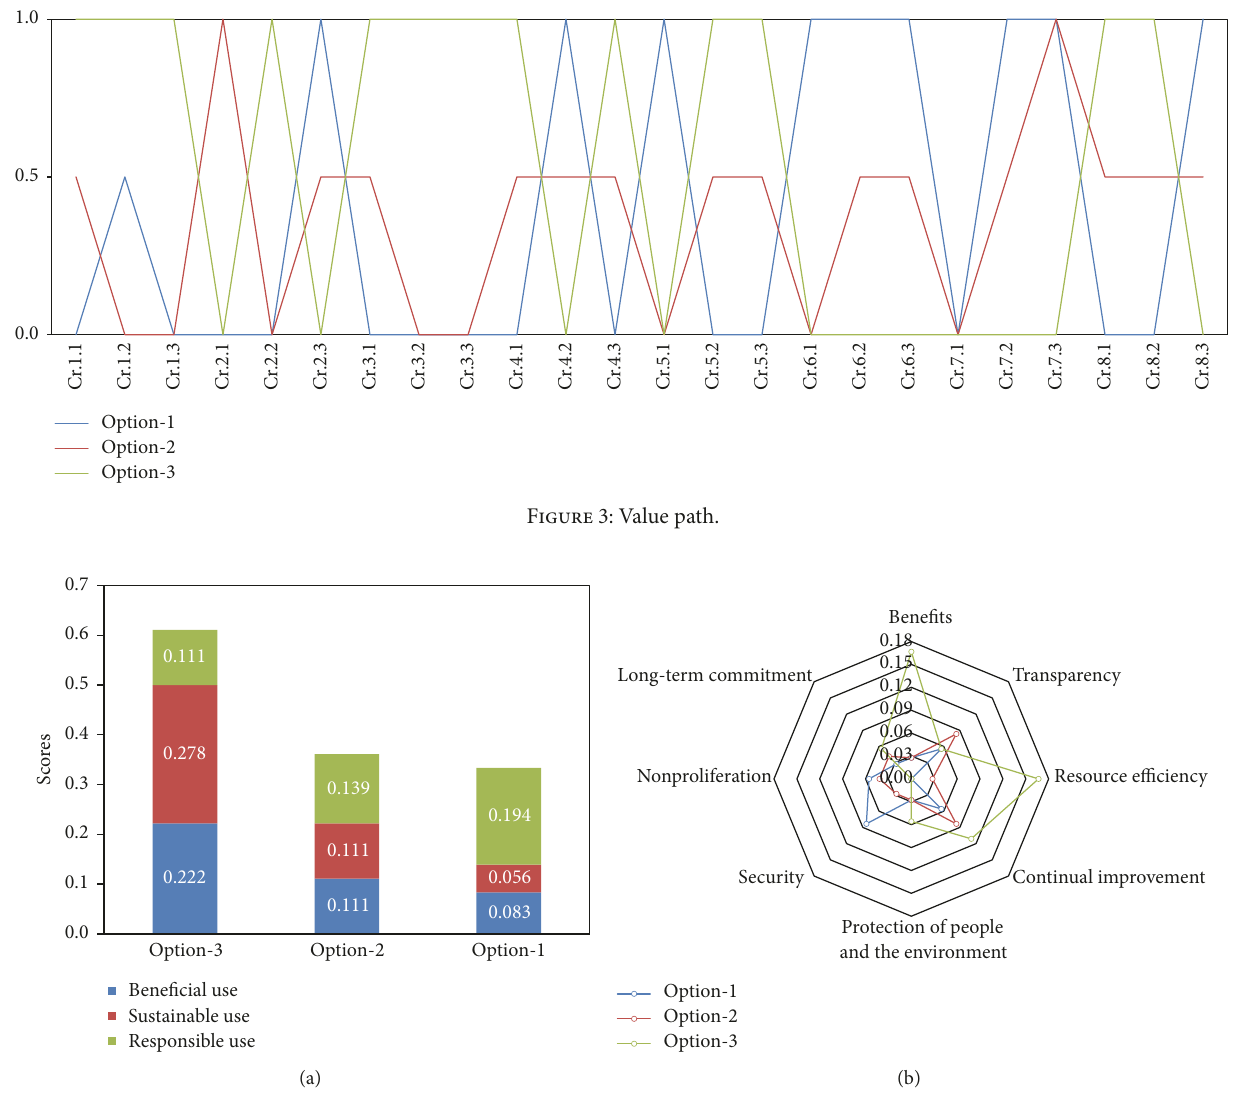
Figure 4: MAVT ranking results for equal weights with breakdown of the total scores into high-level objectives scores (a) and radar chart with shares of individual categories